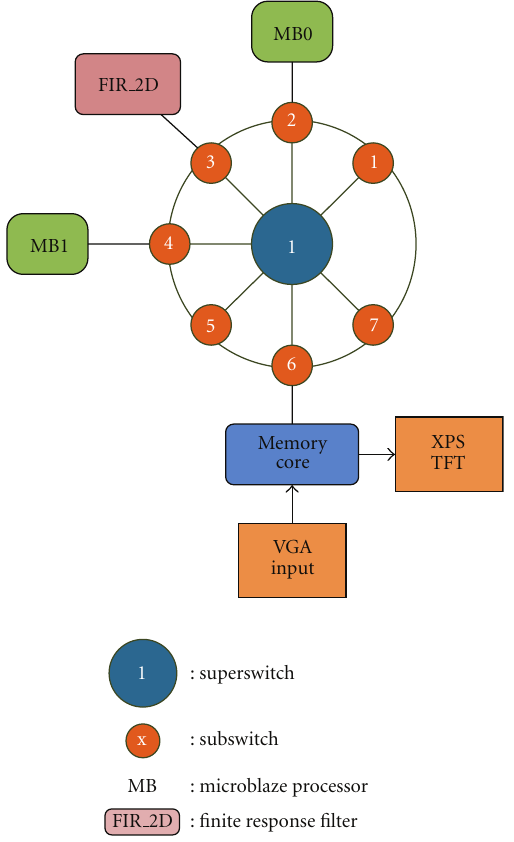
Figure 10: Overview of the test system.